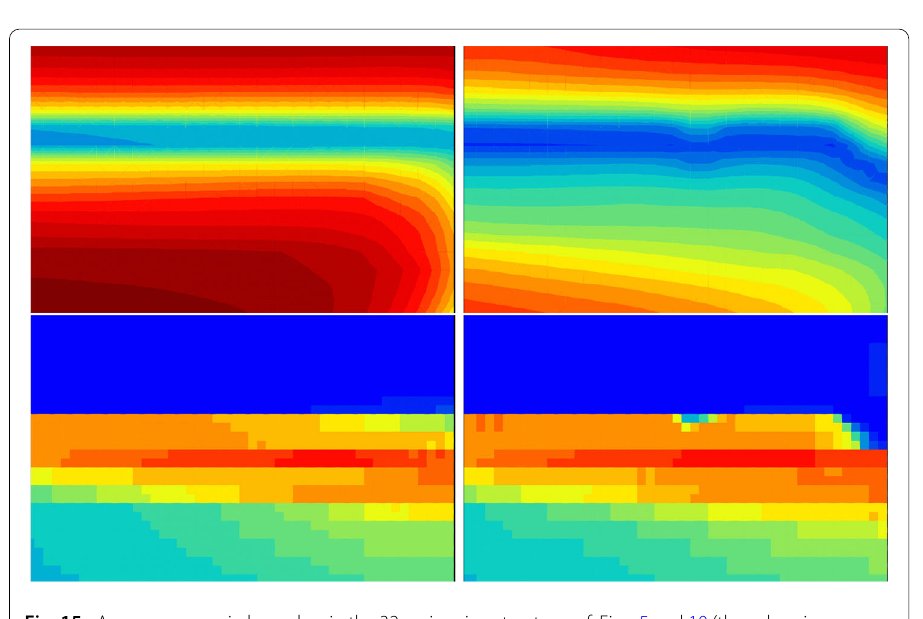
Fig. 15 A zoom on a grain boundary in the 32 grain microstructure, c.f. Figs. 5 and 10 (the subgrain boundary appears in the lower right quadrant of the microstructure in those figures). Top line shows the phase-field φ and bottom line the dislocation density ρ . The images on the left are immediately after the deformation is applied and the images on the right are after 1h of constant deformation. The maximum display value for the dislocation density has not been capped in these images, unlike in previous